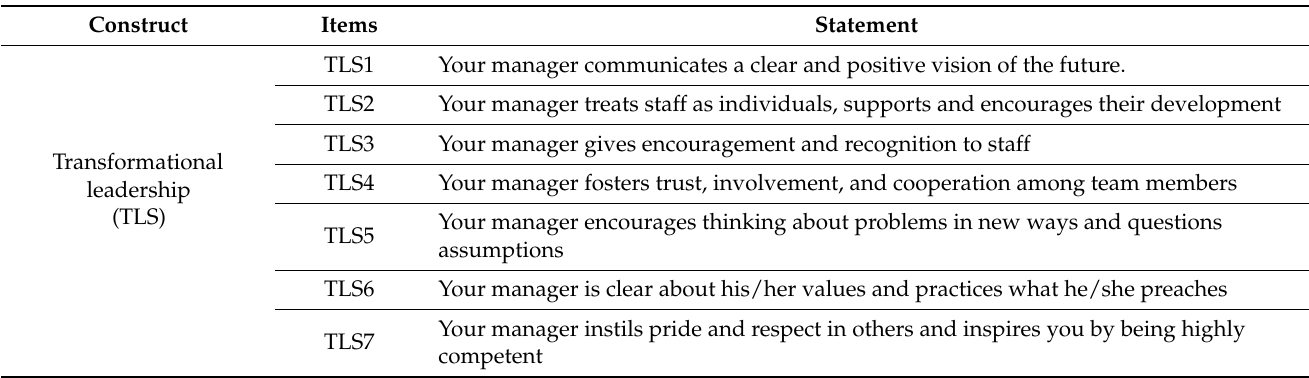
Table A1. Study constructs and their related